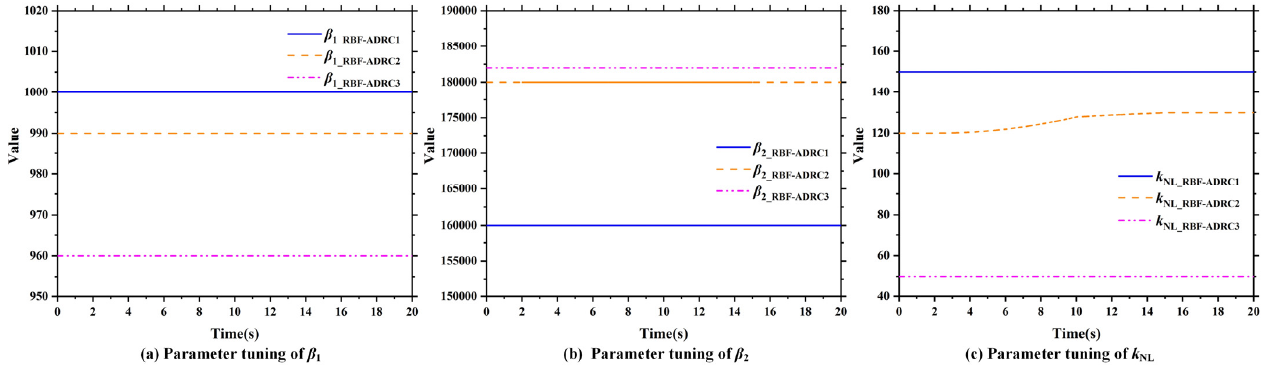
Figure 12. The ESO and NLSEF parameter adjustment curves under speed disturbance.